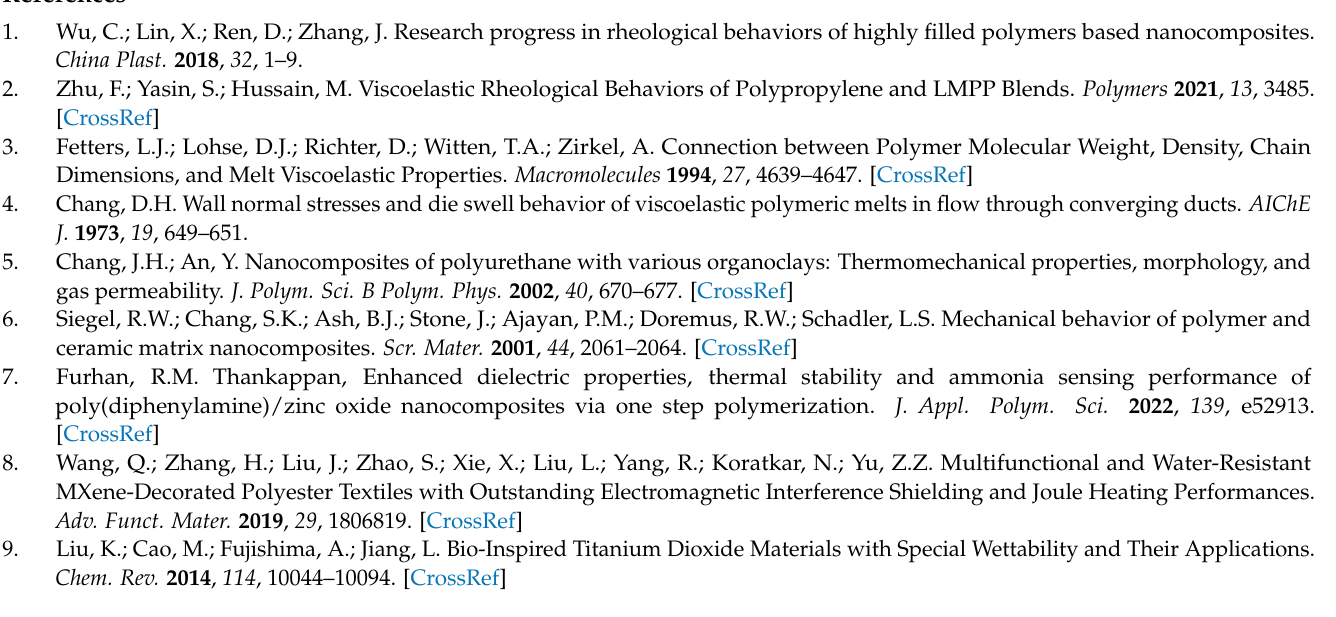
Table S1: Conversion of mass fraction to volume fraction; Figure S2: FTIR results of nano-silica before and after KH570 modification; Figure S3: Schematic diagram of using ImageJ software to measure particle size; Figure S4: The calculations process of Rg; Figure S5: Tan δ exhibits the minimum when the temperature is around 120 ◦ C; Figure S6: The detailed calculation results of